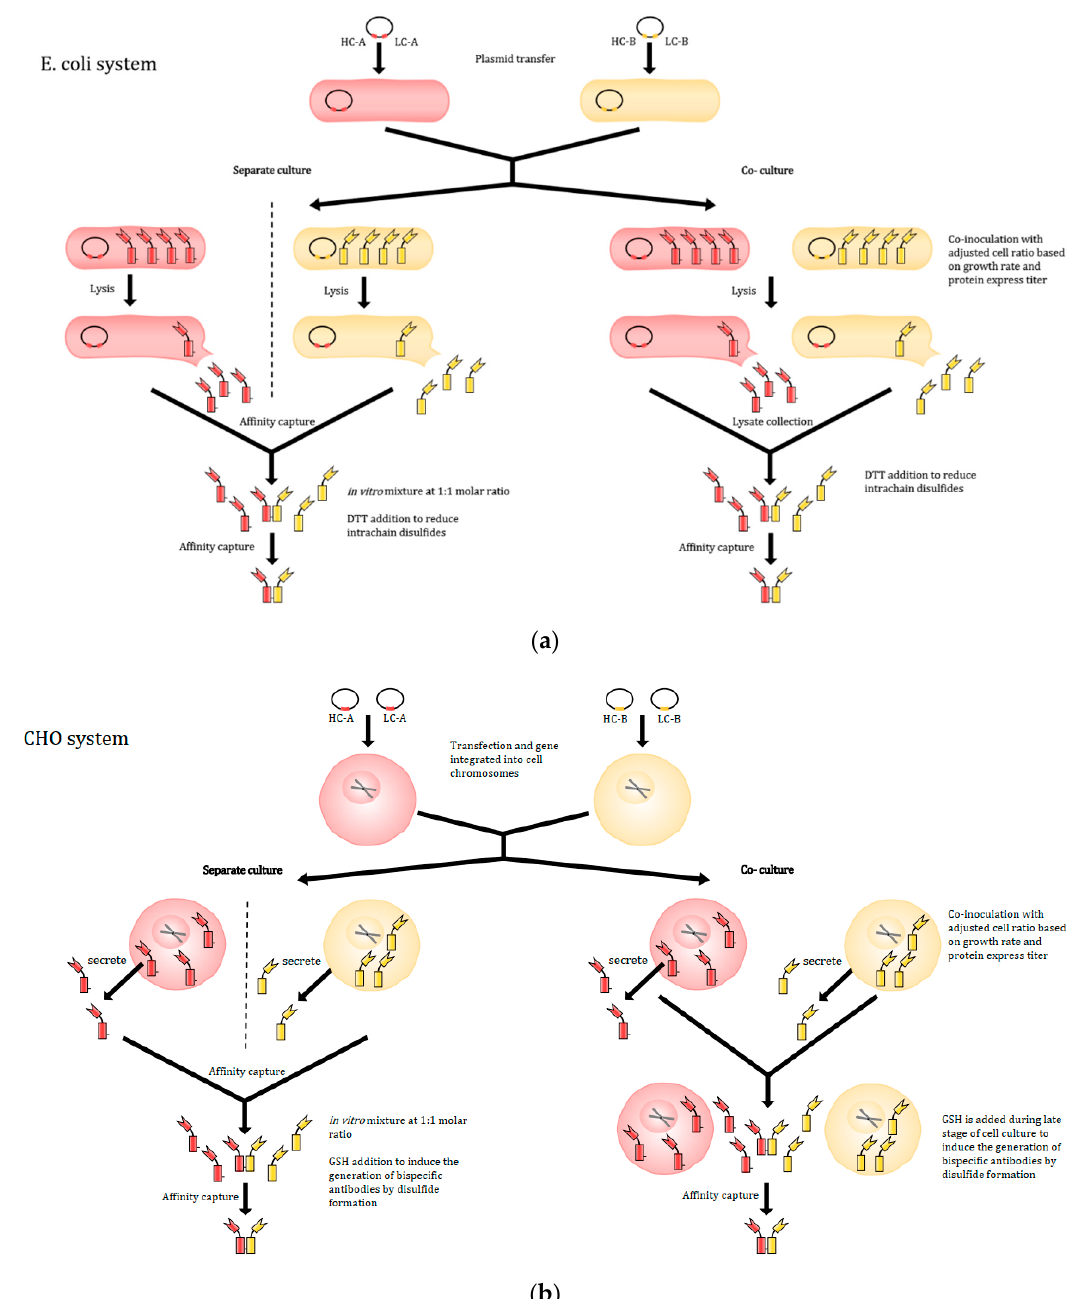
Figure 4. The illustration of the co-culture method to product IgG-like bispecific antibody in E. coli and CHO systems. ( a ) E. coli production vessels are constructed by transferring the cells with individual plasmids containing both heavy and light-chain gene for a half-antibodies. Cell lysis is used to harvest half-antibodies then assembled in vitro. Both separate culture and co-culture system can be used. ( b ) Similar to the E. coli system, CHO cells are co-transfected separate plasmids containing heavy or light-chain gene for a half-antibodies. Secreted antibodies are assembled by GSH induction. GSH: reduced glutathione.